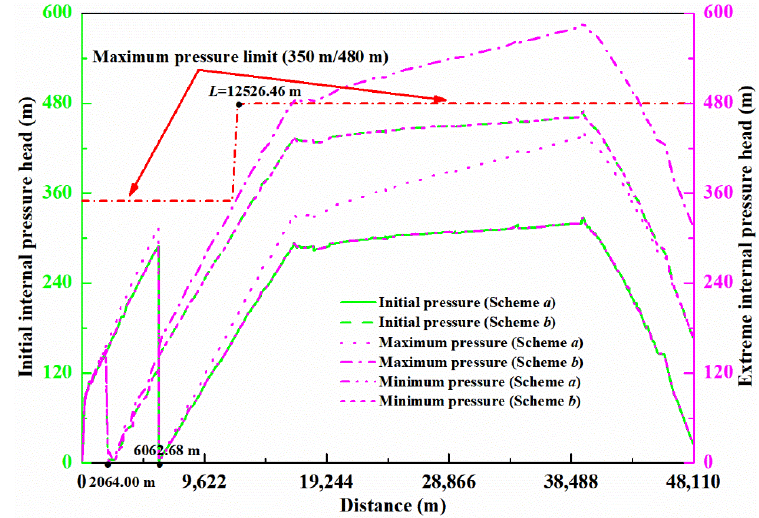
Figure 5. Influence of different locations of EDB on maximum and minimum pressure head in pipelines (schemes a and b ).